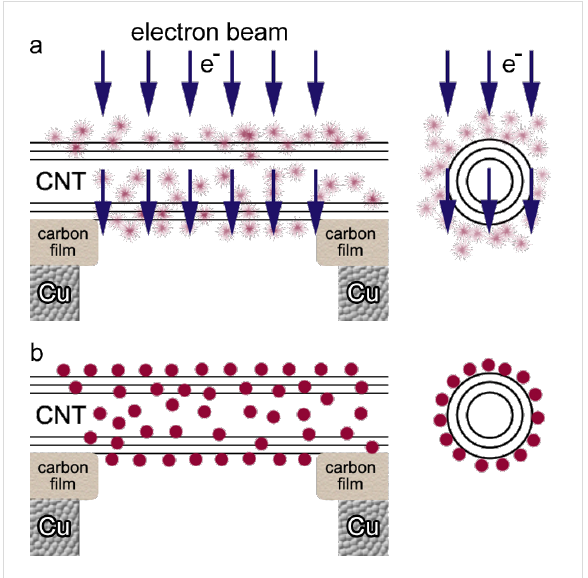
Figure 2: Illustrations of FEBID of nanoclusters on CNT. (a) Precursor gas is all around the CNT since the CNT is not attached to the sub- strate and is suspended above the support grid. CNT is viewed from both radial and axial directions. Electron beams transmit through the CNT as shown. (b) Pt nanoclusters are found all around the CNT as viewed from both radial and axial